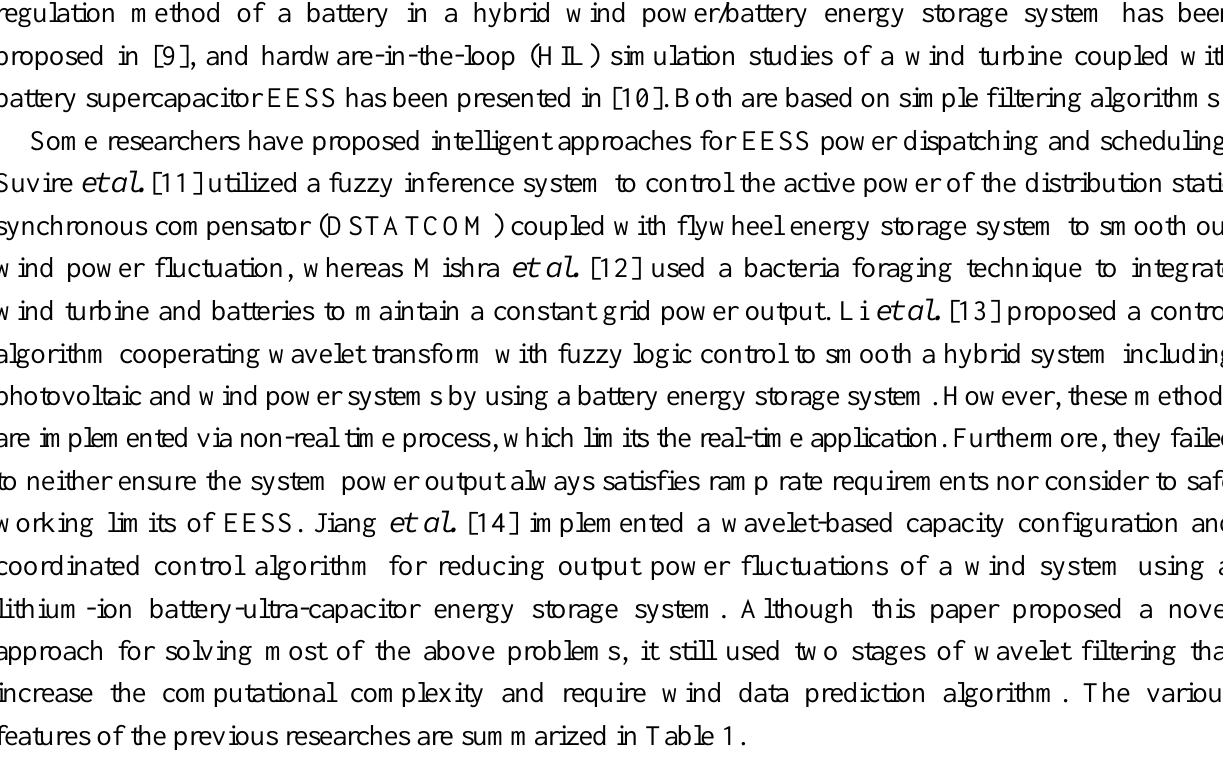
Table 1. Comparison of various wind power smoothing methods. SOC : state-of-charge; SMA: simple moving average; EDLC: electric double-layer capacitor; EMA: exponential moving average; and SMES: superconducting magnetic energy